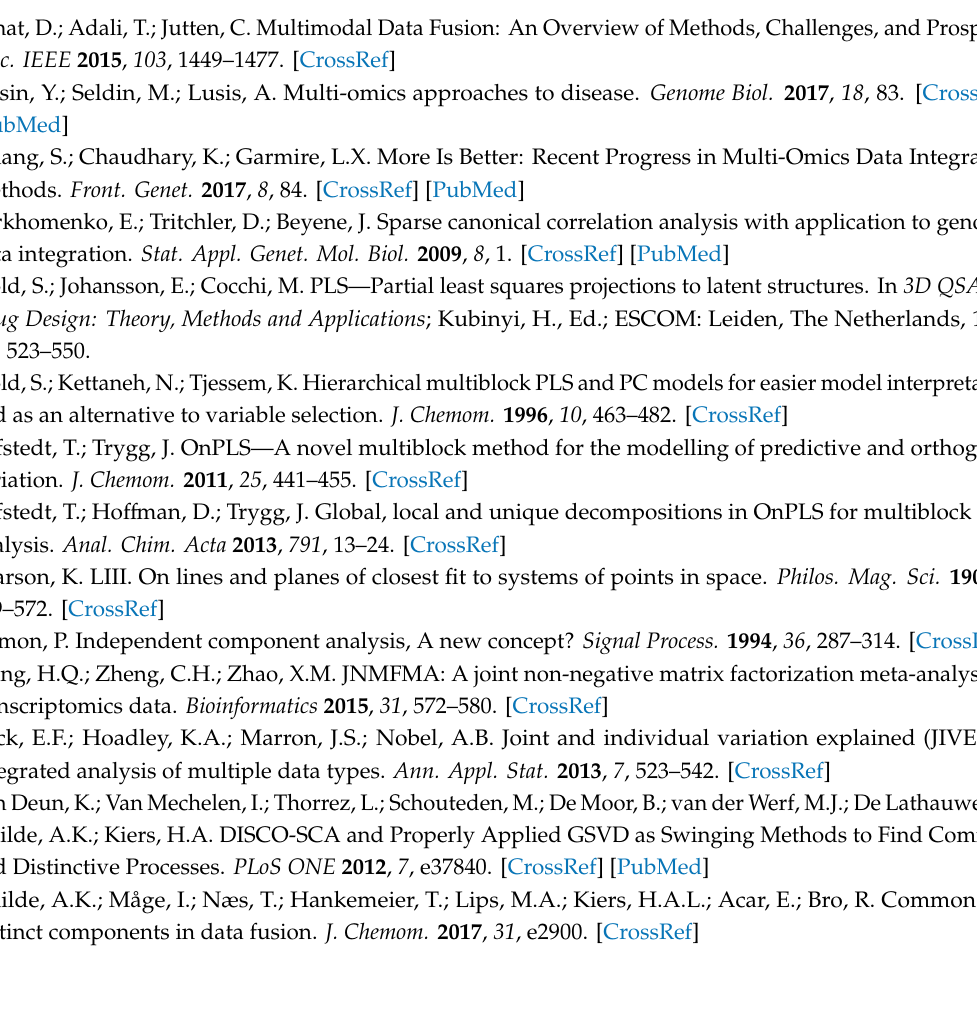
Figure S1: Metadata correlation matrix plot; Figure S2: Concatenated PCA loading p3. Figure S3. Mouse H relative concentrations. Figure S4. Mouse C, G and H relative concentrations. Figure S5. MODY5 / RCAD mutation